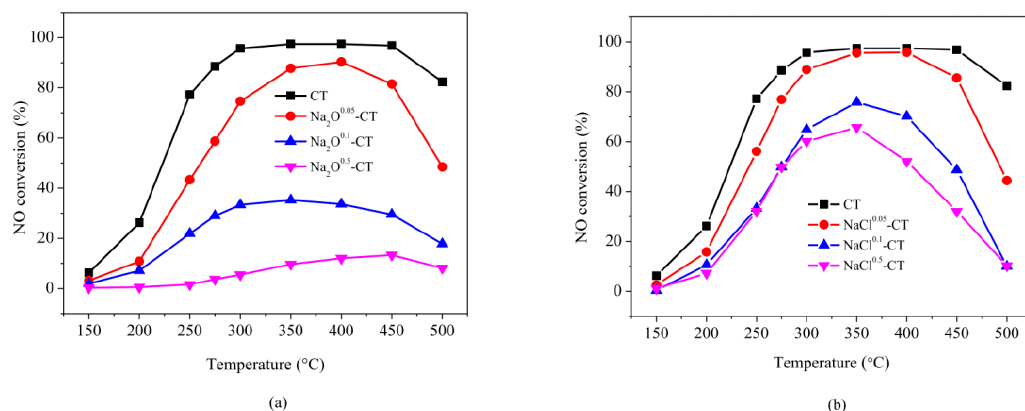
Figure 4. NO conversion of Na 2 O 0.5 -CT ( a ), NaCl 0.5 -CT ( b ). Reaction condition: [NO] = [NH 3 ] = 1000 ppm, [O 2 ] = 3 vol%, N 2 balance, total flowrate = 500 mL/min, GHSV = 90,000 h − 1 [46].